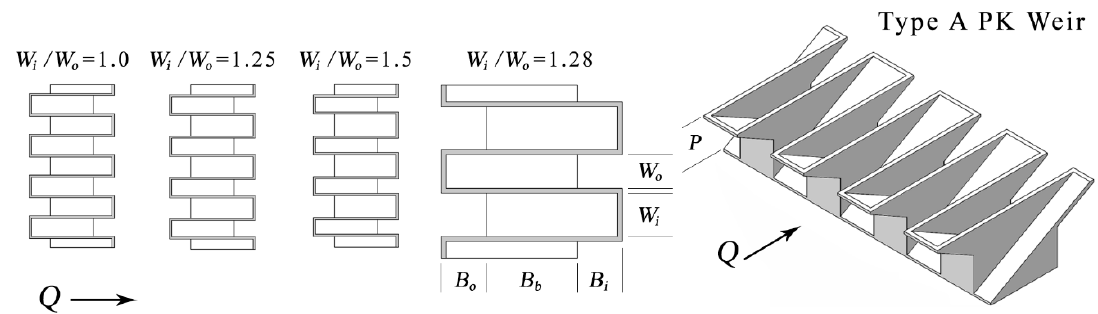
Figure 2. Geometric overview of PK weir geometries investigated herein. Table 1. Type A PK weir energy dissipation model summary.